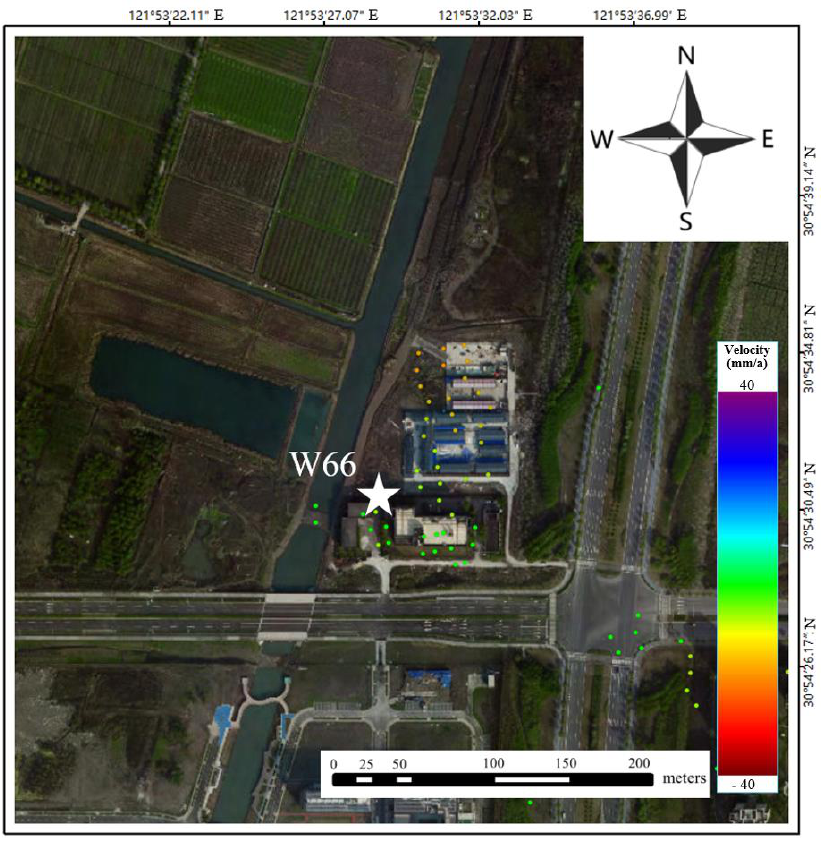
Figure 10. The distribution and deformation rate of PS points around groundwater well W66.